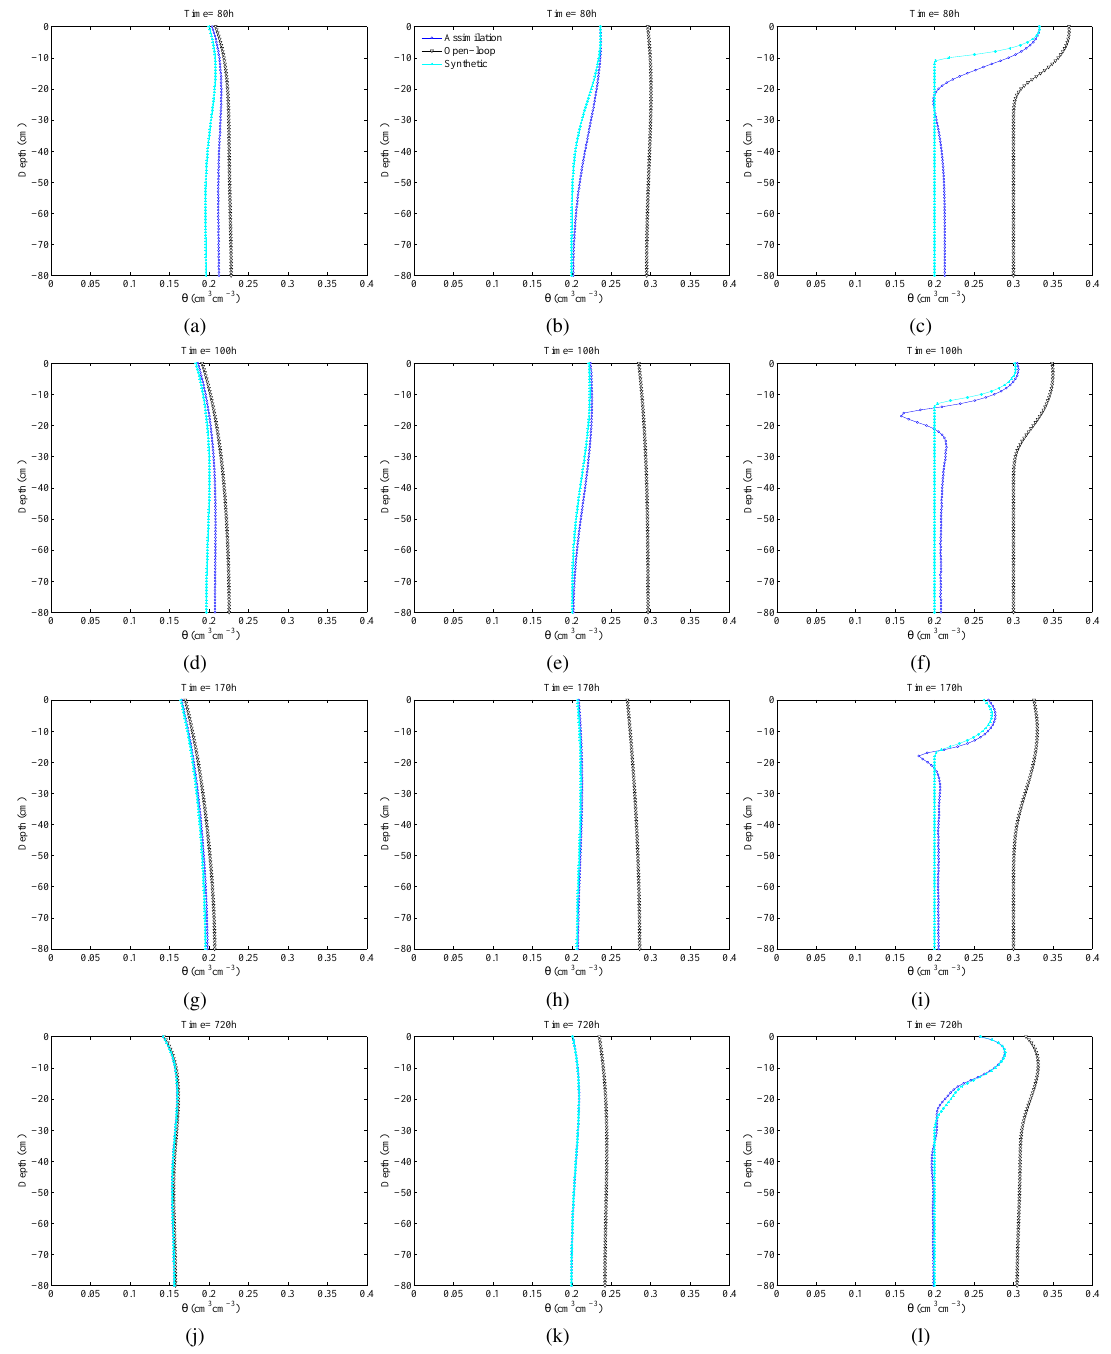
Fig. 5. Comparison of the open-loop and data assimilation with the synthetic soil moisture profile at times 80, 100, 170, and 720h. The assimilation was performed every 10h. The three soil types were accounted for: (a, d, g, j) loamy sand, (b, e, h, k) silt and (c, f, i, l) clay. better than the open-loop prediction for all soil types.